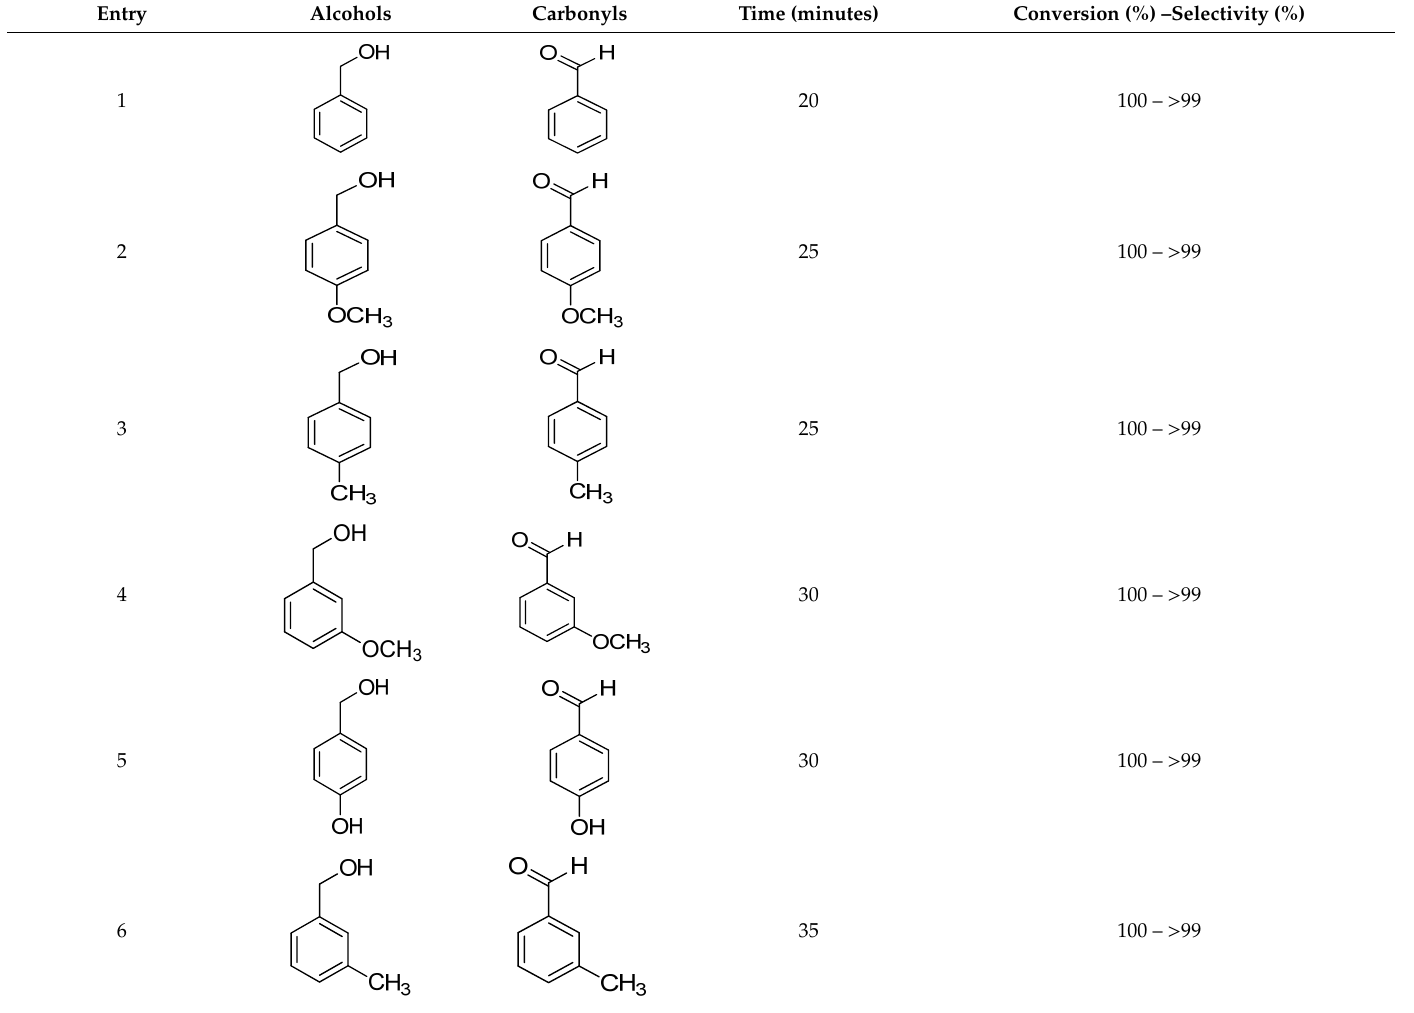
Table 6. (1%)Co x O y –MnCO 3 -catalyzed oxidation of different kinds of alcohols employing gaseous O 2 under free-alkali circumstances.